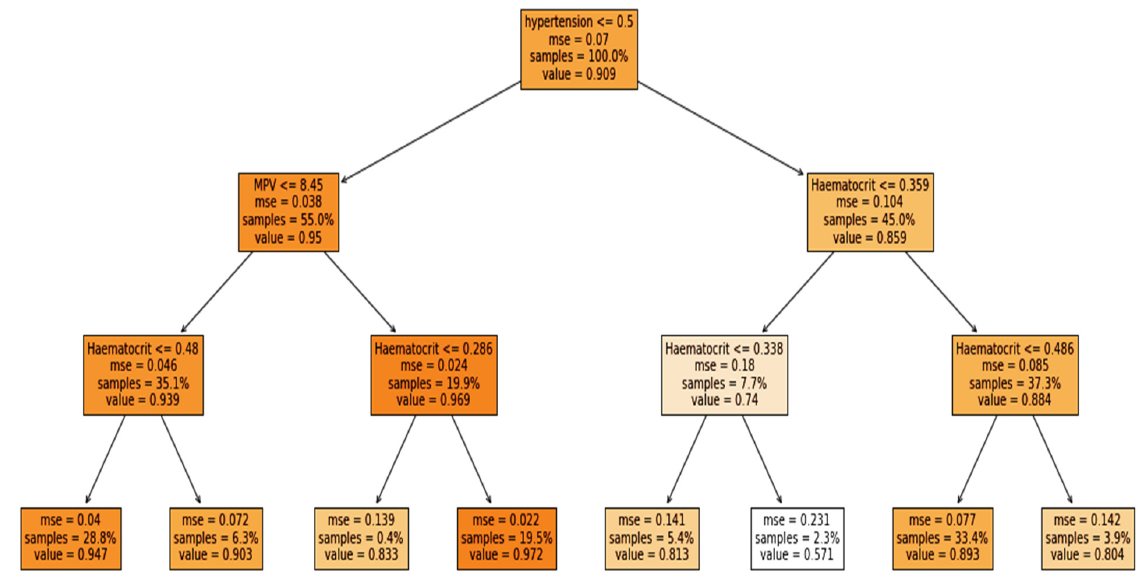
Figure 11. Case 1: Mortality rate with binary classification.